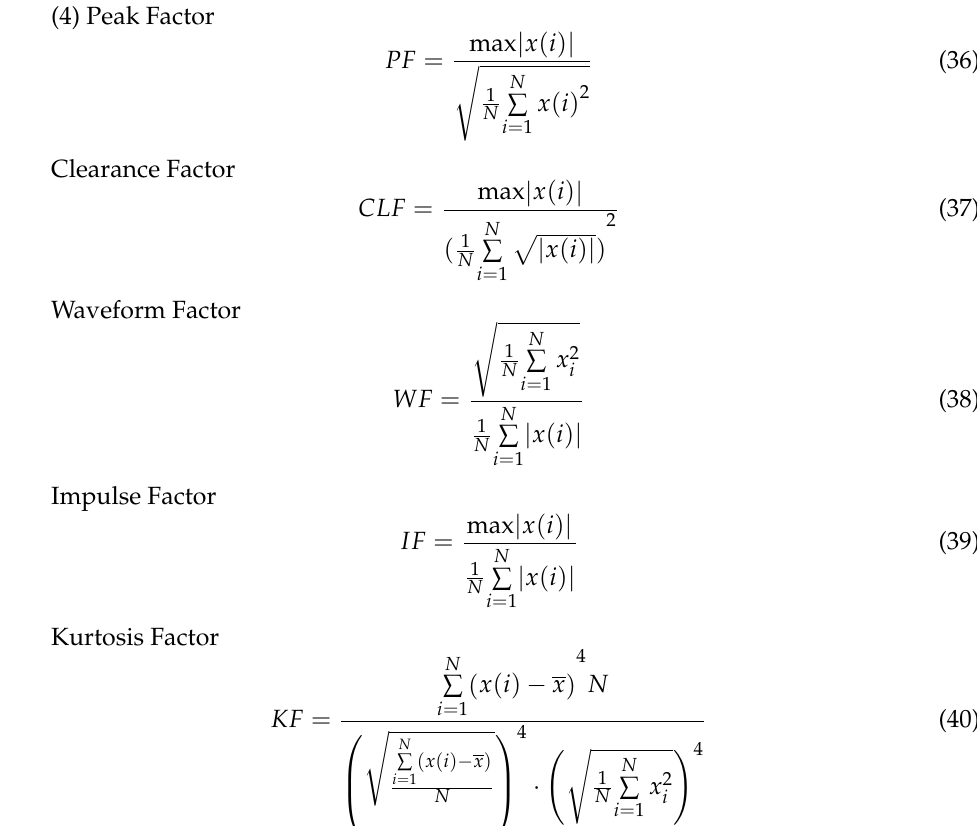
Figure 18. Comparison between the actual and predicted values by GA_BP_NN.